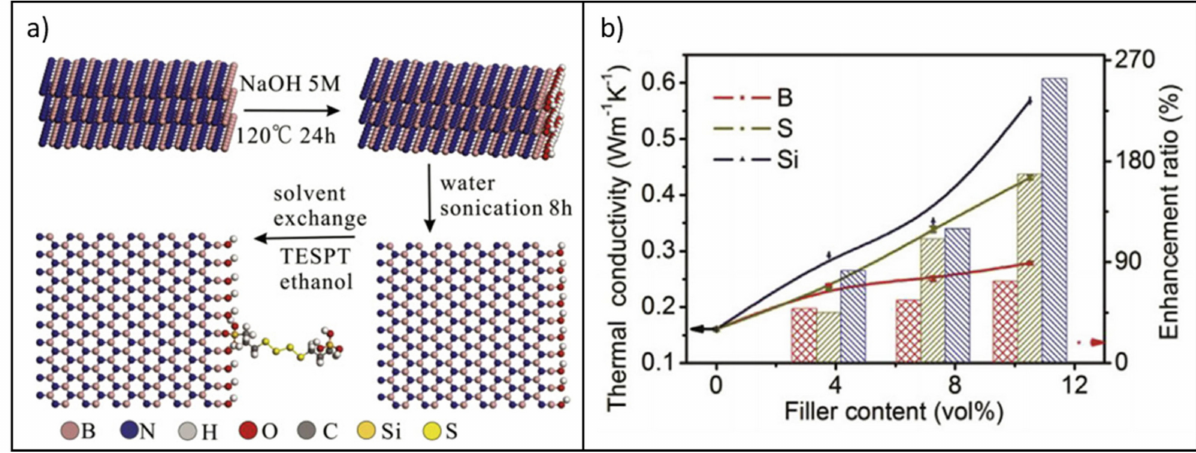
Figure 16. ( a ) Scheme of the preparation procedure for BNNS slurry; ( b ) thermal conductivity and enhancement ratio of SBR/BN (B), SBR/BNNSs (S), and SBR/Si-BNNSs (Si) composites at different filler loadings. Adapted from